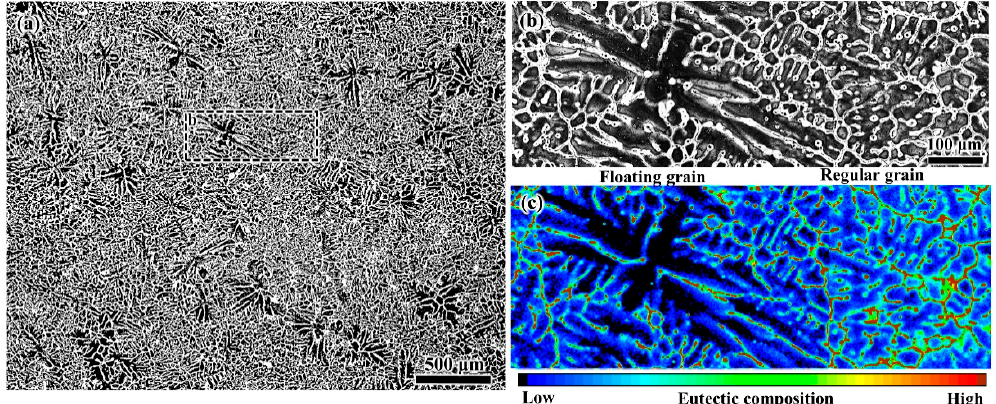
Figure 5. ( a ) Microstructure results at billet center after etching by Weck’s reagent, ( b ) typical duplex grain structure, ( c ) eutectic composition results obtained with EPMA.